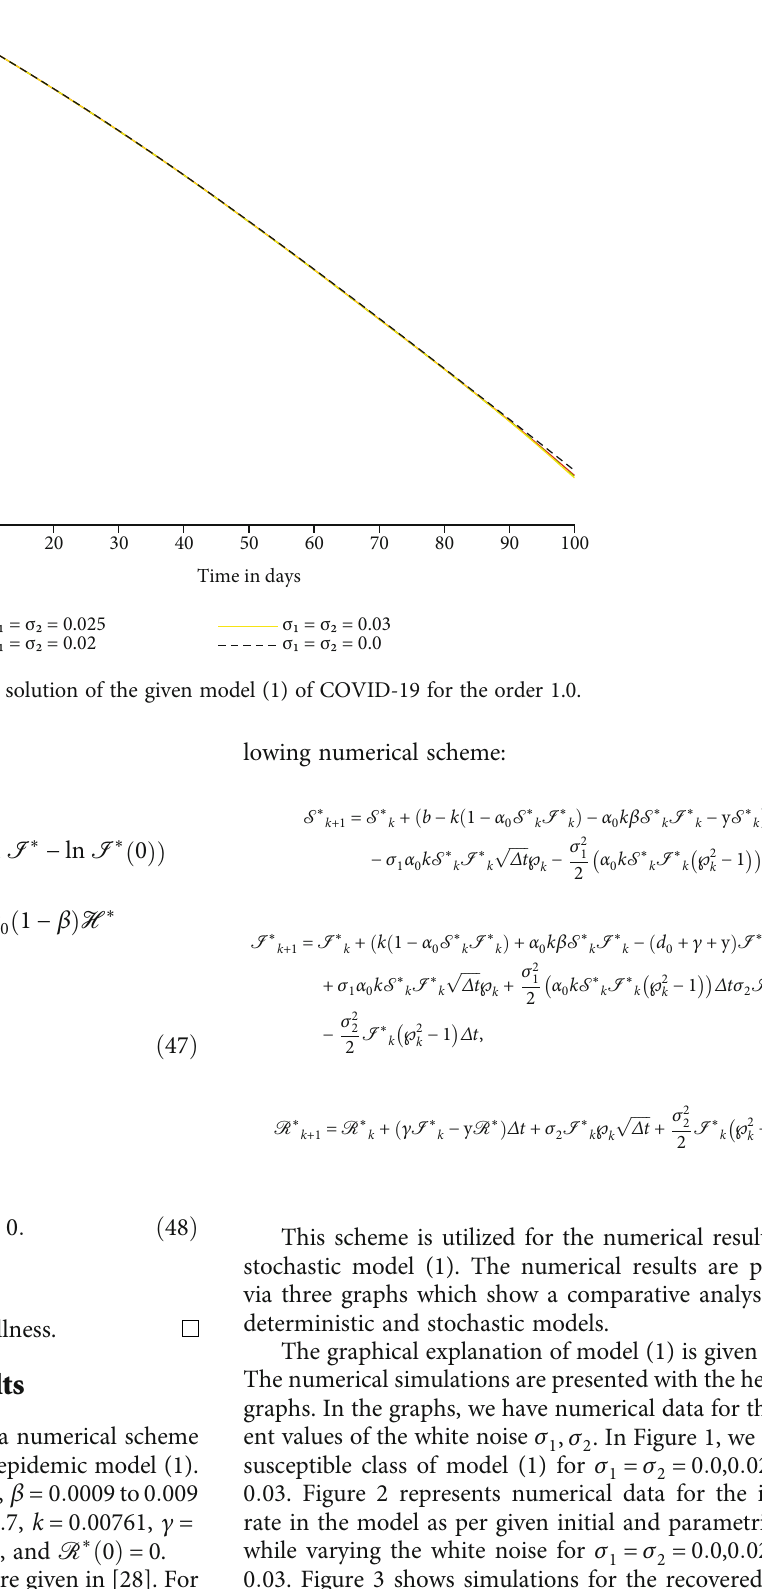
= σ = 0 : 0,0 : 02, 0 : 025, 1 2 = σ = 0 : 0,0 : 02, 1 2